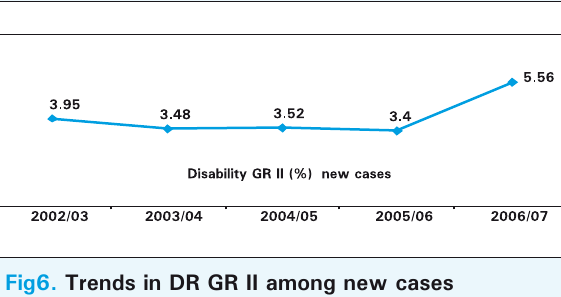
Fig 5. trends in selected indicators over the past 5 years